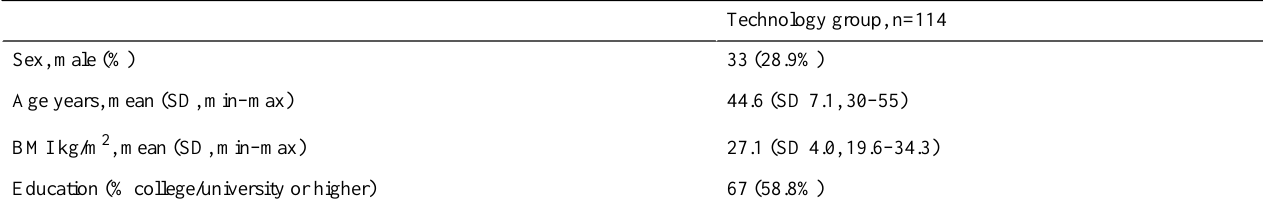
Table 1. Baseline characteristics of